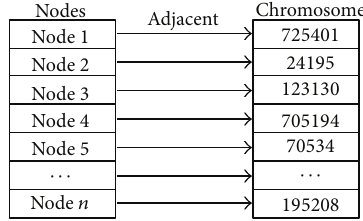
Figure 2: Node chromosome